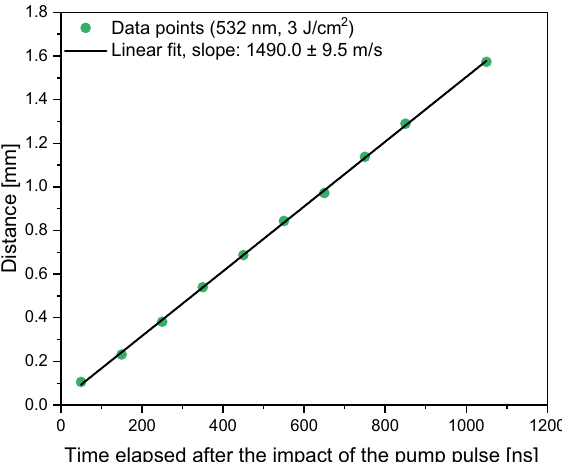
Figure 10. Distance of the wave front from the pastille surface as a function of time. The data points are from the fast photography measurements (λ = 532 nm, F = 3 J/cm 2 ).